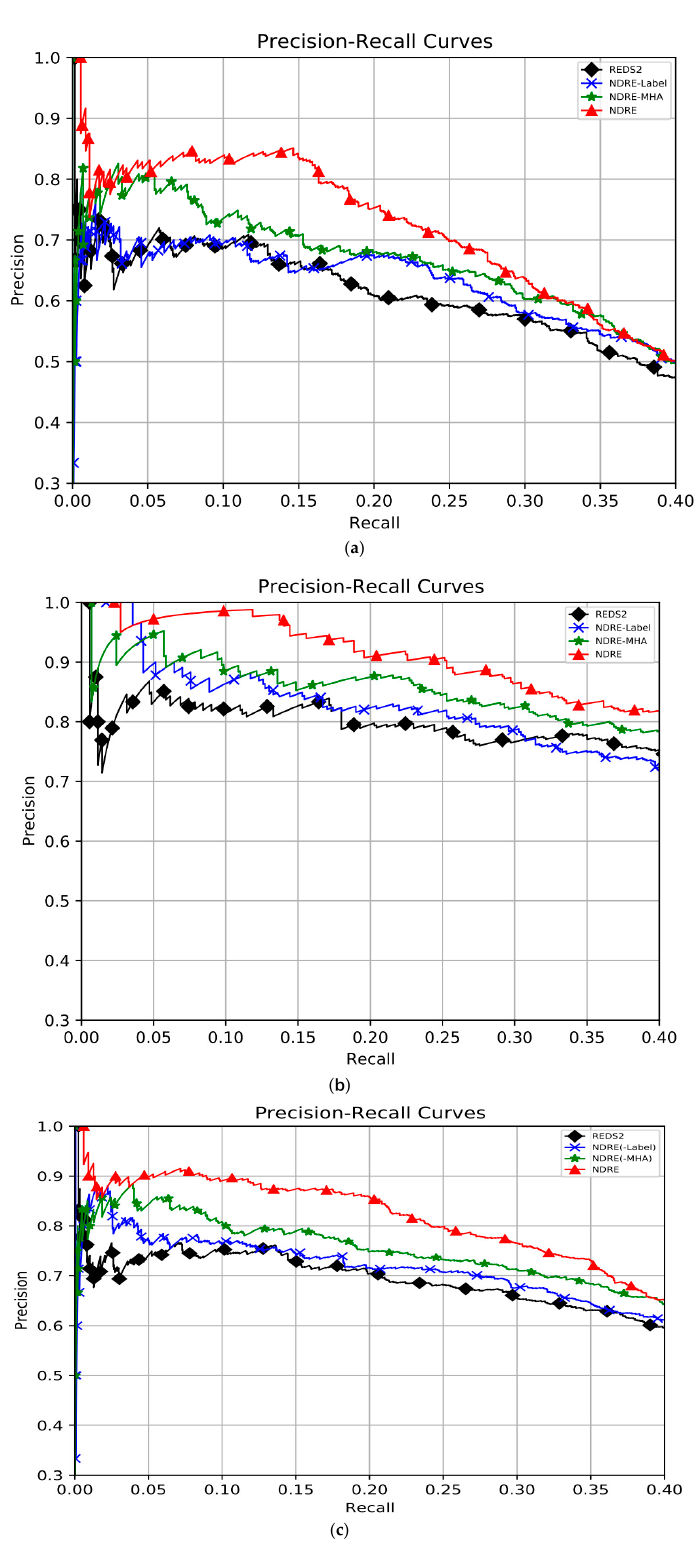
Figure 5. Aggregate precision–recall curves of REDS2, NDRE(-Label), NDRE(-MHA), and NDRE under different testing modes: ( a ) single, ( b ) multiple, and ( c )